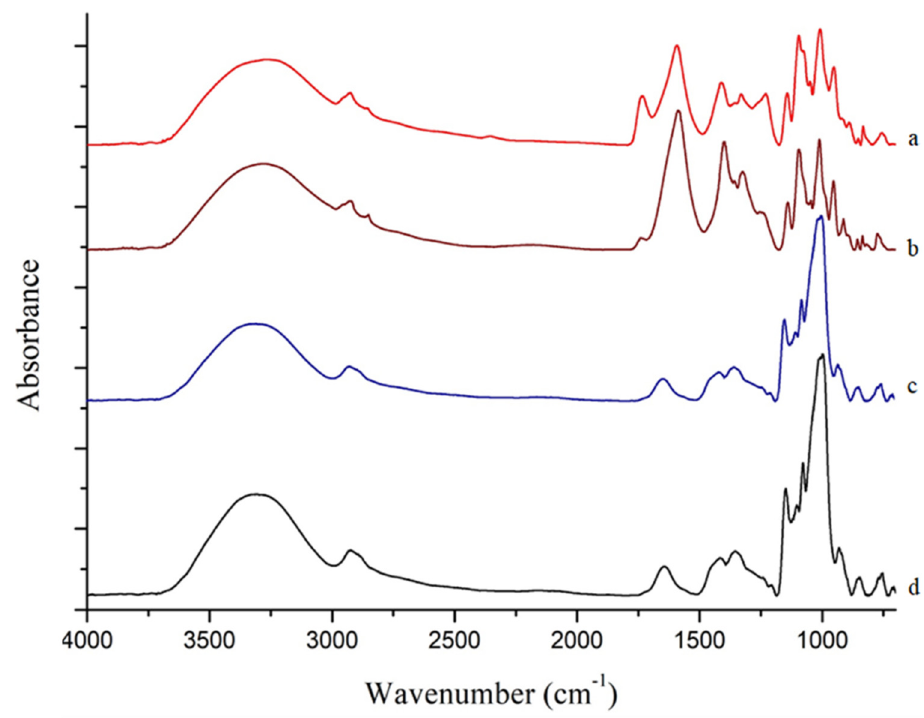
Figure 5. FTIR spectra of JFP and JFP/pullulan nanofibers: ( a ) JFP; ( b ) EDTA extracted JFP; ( c ) pullulan nanofibers; ( d ) JFP/pullulan nanofibers (1J12P1T305).